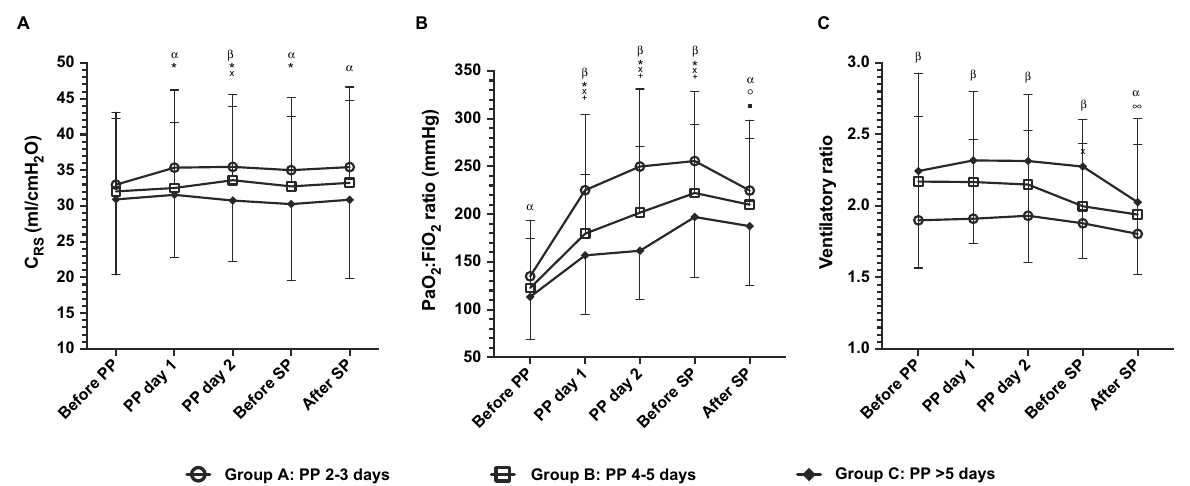
Fig. 1 Respiratory system compliance, PaO2:FiO2 ratio and ventilatory ratio along prone positioning. Lines and symbols show mean and standard deviation of each variable before prone positioning (PP), at day 1 and at day 2 in prone, before supine position (SP) and after back to SP; C RS : respiratory system compliance. *, x, : p ‑value < 0.001 for comparisons of different time points with their respective pre‑PP values in patients + from group A, B, and C, respectively.°, ▪ , : p ‑value < 0.001 for comparisons between before SP and after SP in patients from group A B , and C , ∞ respectively. α: p ‑value < 0.01 for inter‑group comparisons at different time points. β: p‑value < 0.001 for inter‑group comparisons at different